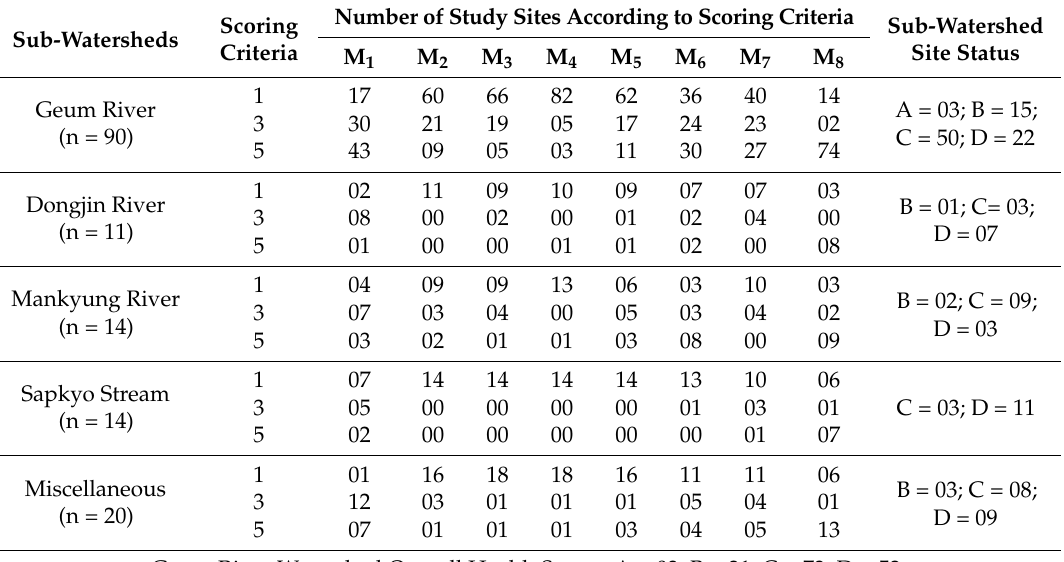
Table 5. Distribution of sites based on obtained mmIBI 08 values in Guem River